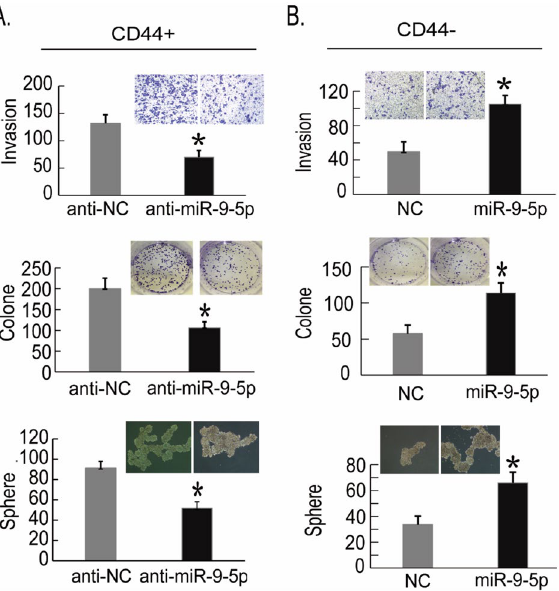
Figure 4. MiR-9-5P has a promoting role in CD44+ PCSCs. ( A ) After sorting of CD44+ and CD44− PC3 PCa cells by flow cytometry, decreased expression of miR-9 in the CD44+ PC3 cells was mediated by the transfected miR-9 inhibitor, and the invasion, clone formation and sphere formation abilities of CD44+ PC3 cells were detected 48 h later. ( B ) Sorting of CD44+ and CD44− PC3 PCa cells was performed by flow cytometry, and high expression of miR-9-5p was detected in the CD44− PC3 cells transfected with the miR-9-5p mimic. After 48 h, the invasion, clone formation and sphere formation abilities of CD44− PC3 cells were detected. The results are represented as the mean ± S.D. from three independent assays. * P < 0.05.